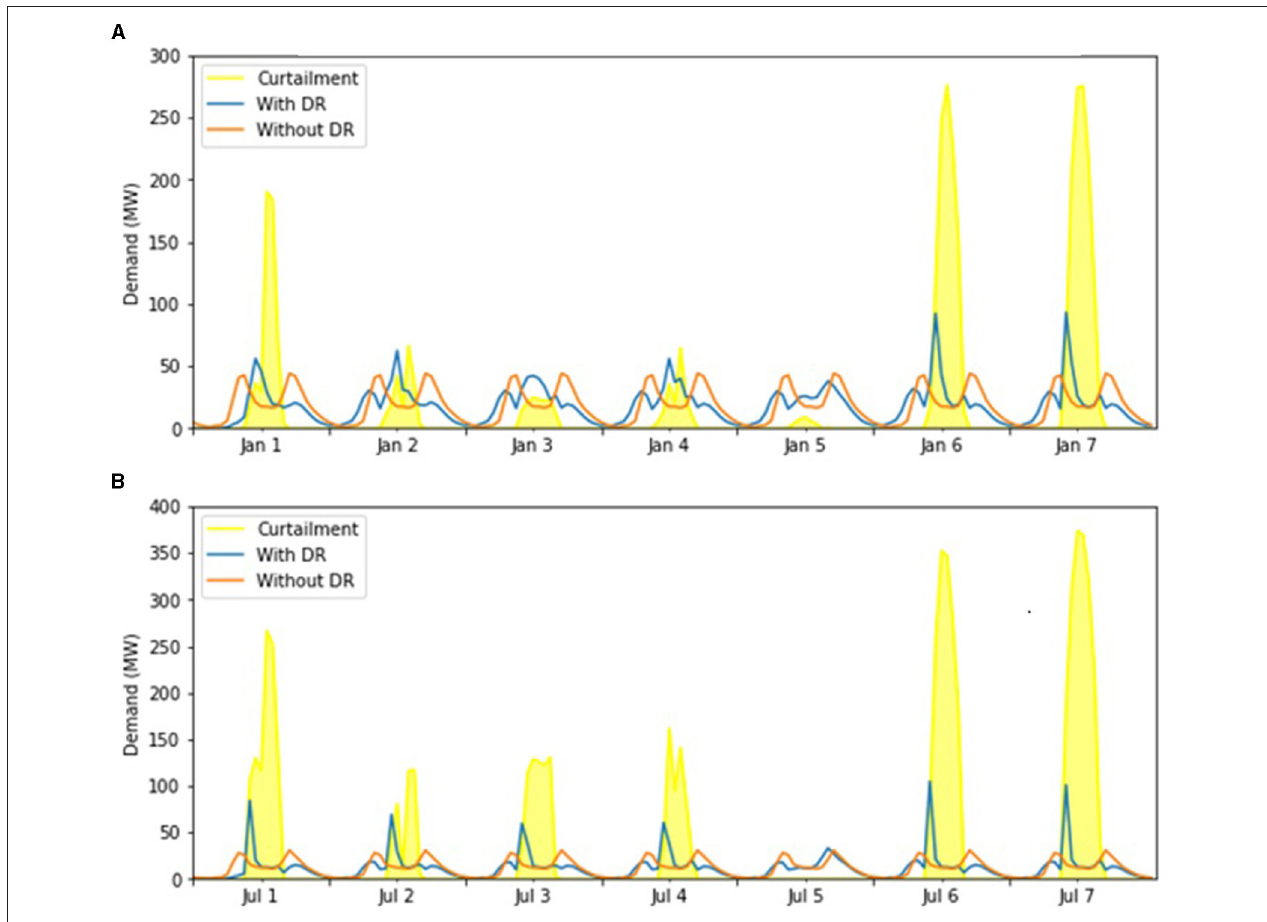
FIGURE 11 | Time-shifting of EV demand load due to curtailment within Scenario 3B in the (A) winter (top) and (B) summer (bottom).